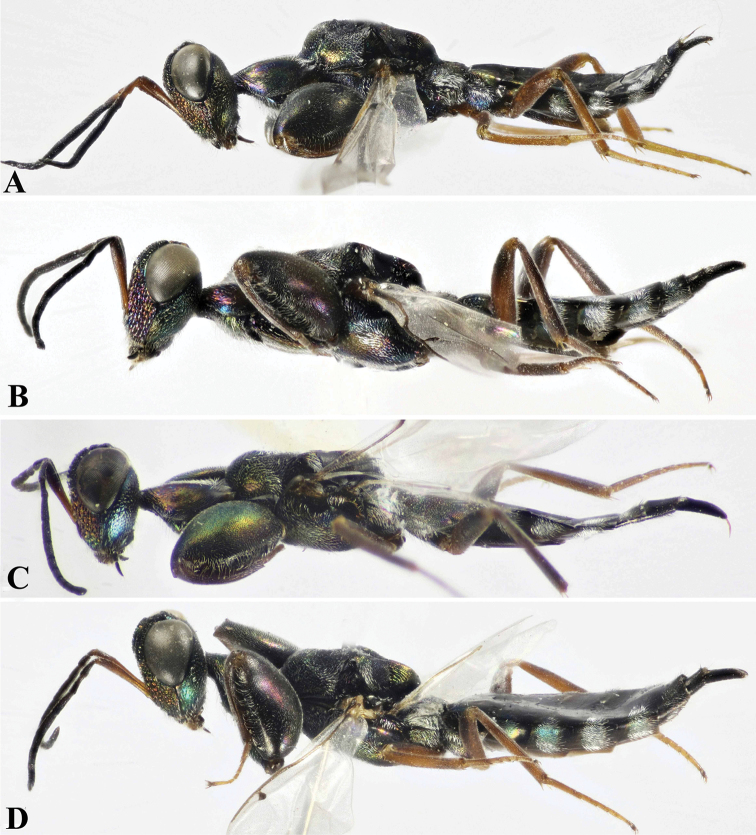
Lateral habitus, Holotype AOodera
arabica sp. nov. BOodera
omanensis sp. nov. COodera
rapuzzii sp. nov. DOodera
similis sp. nov.